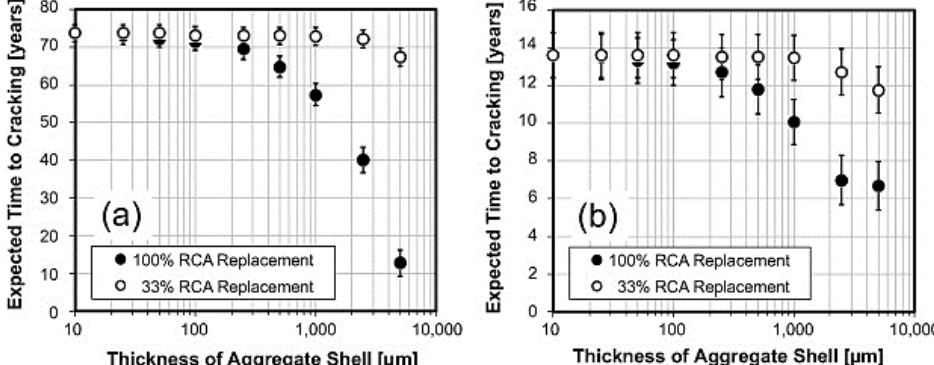
Figure 4. Effect of RA content, with variable thickness of aggregate shell (volume of attached mor- tar/aggregate specific surface): ( a ) concrete made with mildly chloride-contaminated (1 kg/m 3 ) RA and exposed to a mild chloride environment; ( b ) concrete made with severely chloride-contaminated (3 kg/m 3 ) RA and exposed to a severe chloride environment. Reproduced with permission from Ref. [95]. 2015, Elsevier.